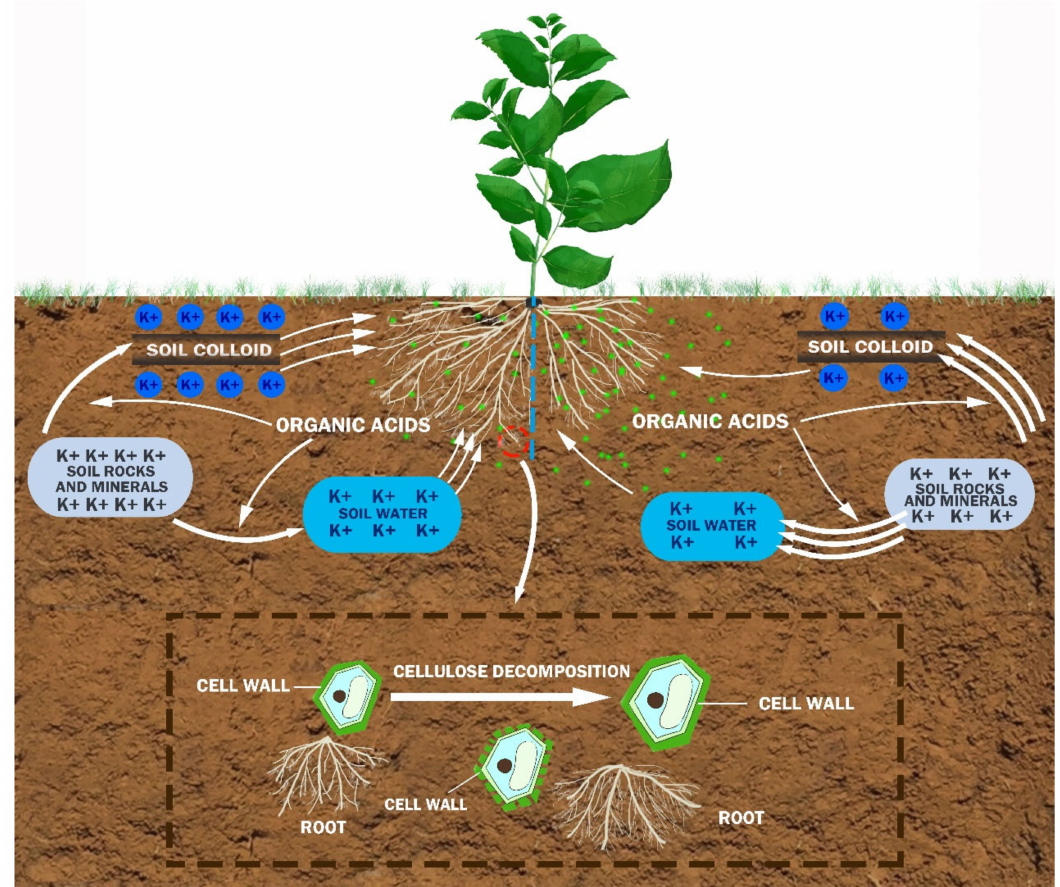
Figure 9. A conceptual diagram illustrating the foraging strategy of tea roots under K